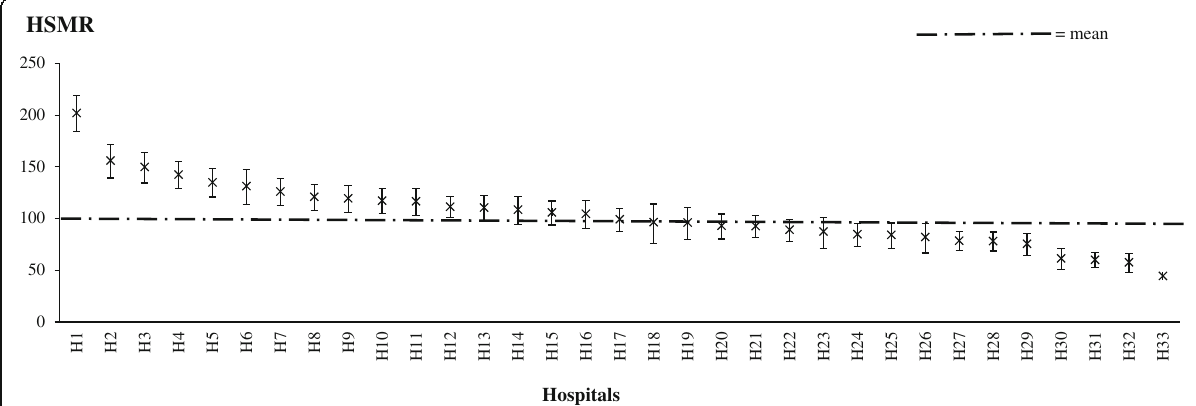
Fig. 3 Caterpillar plot of the HSMR for pneumonia (9-year model, 2010 – 2018, n = 33) for each hospital. The HSMR is graphed as the upper and lower 95% confidence limits. HSMR hospital standardized mortality